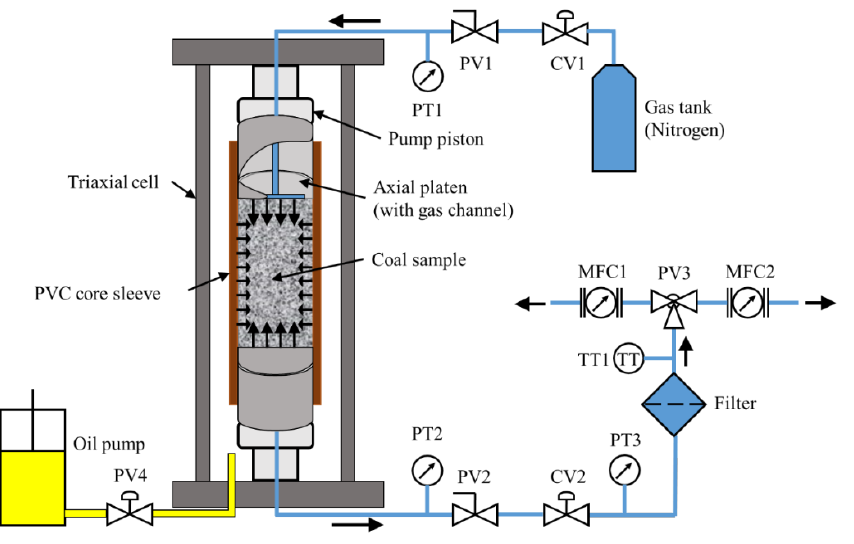
Figure 5. Schematic of the experimental set-up.